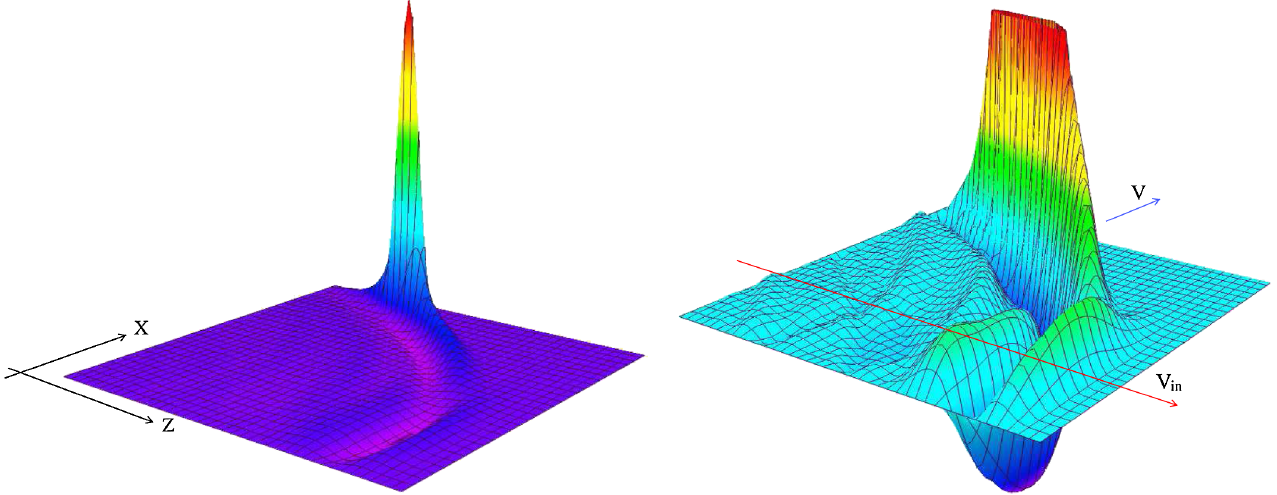
FIG. 11. Coherent edge radiation. Distribution of the magnetic field on the horizontal plane in the vertical middle of the vacuum chamber. The large peak corresponds to the bunch field. The right picture is a magnified image of the left picture. Note the scales in the X and Z directions are different. A red arrow shows the initial bunch X position and the direction of the bunch velocity. A blue arrow shows the direction of the bunch velocity at this